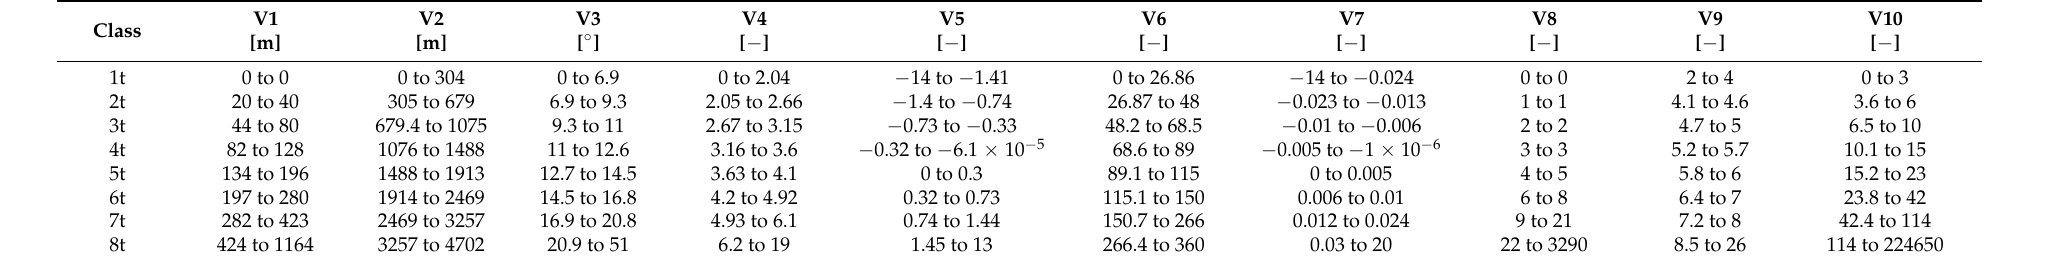
Table 4. Classification of the independent variables employed in the statistical analyses carried out at